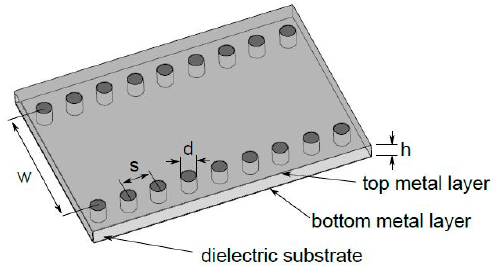
Figure 3. Geometry of a section of SIW.